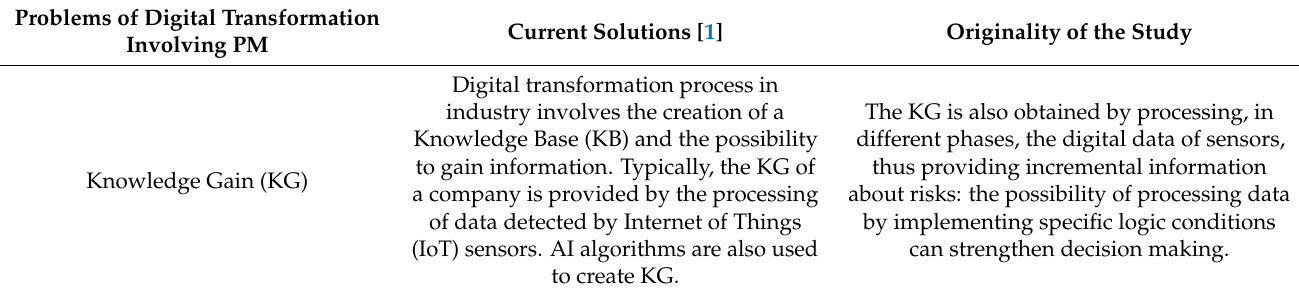
Table 1. Problems of digital transformation, current solutions, and aspects concerning originality of the